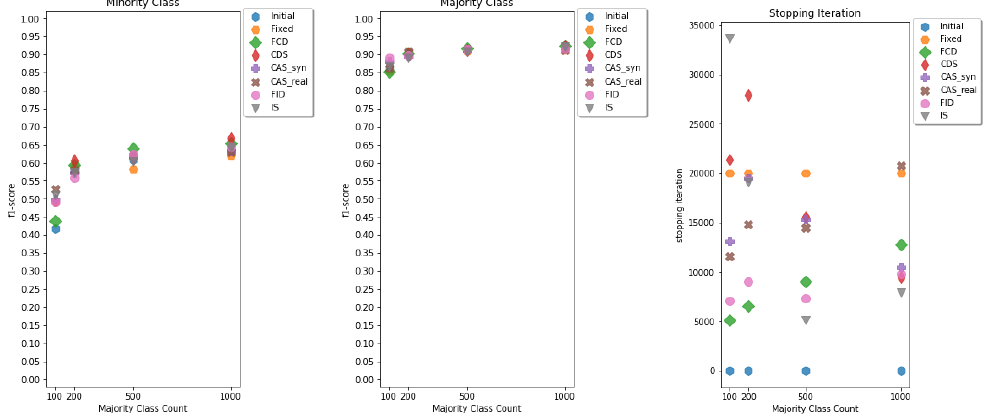
Figure 18. Average F1 results of cifar17-based datasets by imbalance ratio for minority ( left ) and majority ( center ) classes, and average number of iterations until the training is stopped ( right